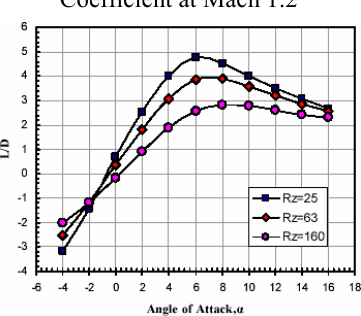
Fig. 14 Comparison of pitching moment Coefficient at Mach 1.2